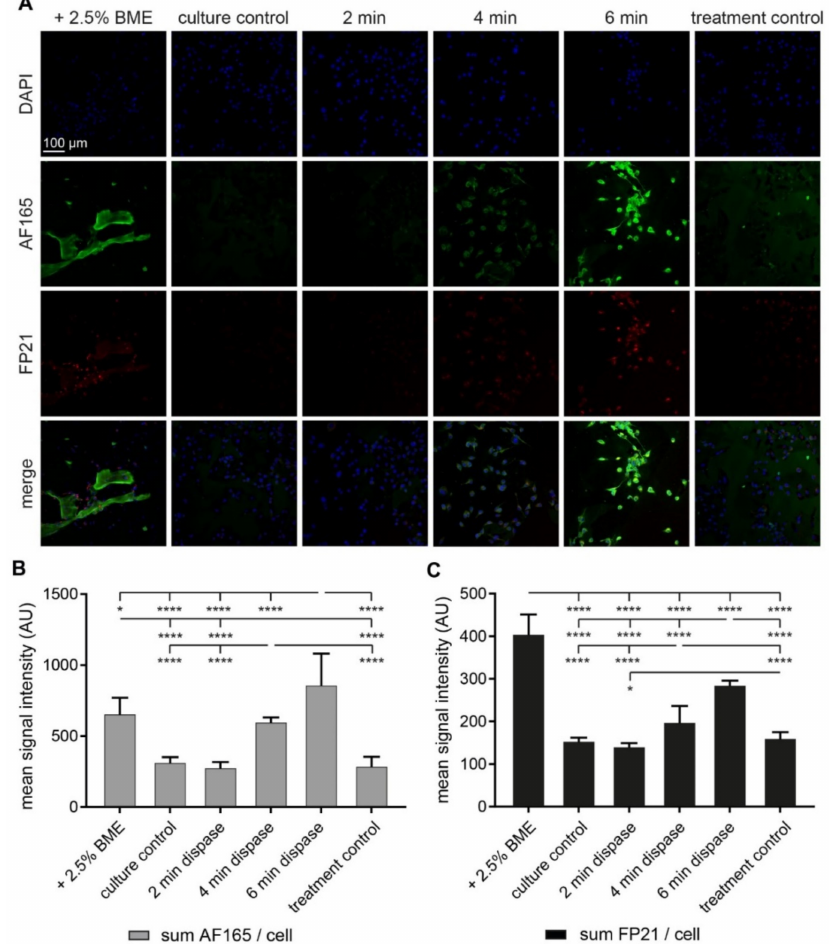
Figure 2. BME and short-term protease treatment enhance bone sialoprotein (BSP) immunofluores- cence. 1,200,000 MDA-MB-231 cells were seeded in Petri dishes containing glass cover slips. After 2 d, one culture was supplemented with 2.5% BME within the media. Alternatively, no BME was added and after 4 d, cultures were treated with either dispase for exposure times as indicated, or with fresh media as treatment control. All cover slips were then fixed and stained for DAPI and human BSP (AF165 and FP21). ( A ) Representative confocal images in sum projections. ( B , C ) Graphs showing quantitative analysis of fluorescence intensities per cell. Mean + SD ( n = 3; * p < 0.05, **** p <